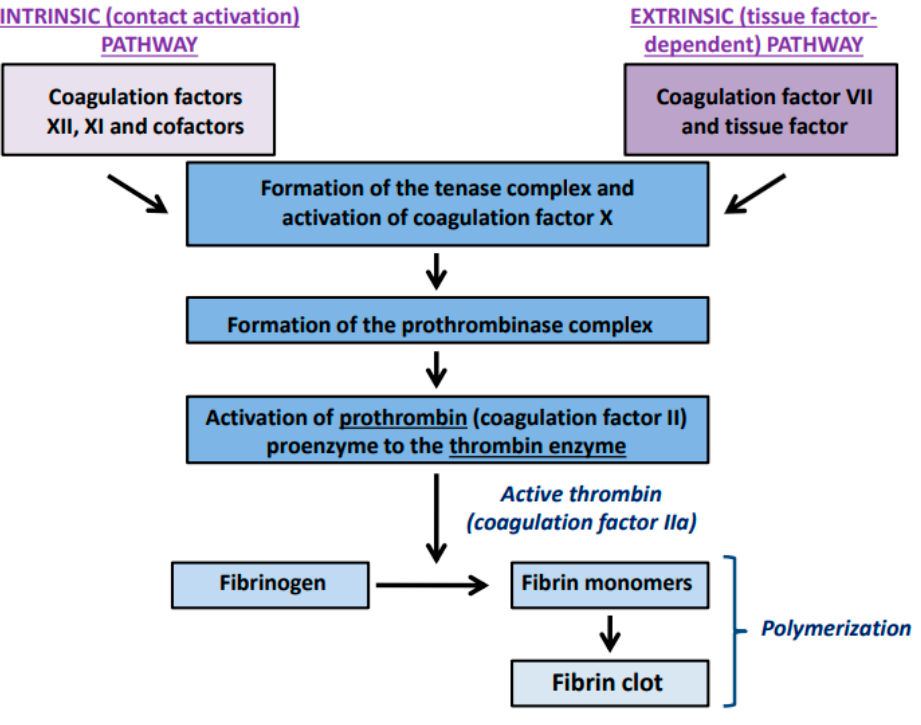
Figure 1. Key steps in the blood plasma coagulation cascade. The extrinsic pathway is activated by the tissue factor, which is abundantly expressed in the subendothelial tissue but becomes available to blood plasma proteins after vascular injury. Induction of the intrinsic coagulation pathway requires activation of the coagulation factor XII and the presence of a high-molecular (HMW) kininogen and prekallikrein. Independently on the starting point, both pathways trigger the tenase and prothrombinase enzymatic complexes, leading to the generation of the thrombin enzyme. The thrombin-catalyzed removal of short peptides from the fibrinogen molecule activates fibrinogen polymerization and the formation of fibrin monomers and polymers. This complex cascade of reactions results in the conversion of soluble fibrinogen into an insoluble fibrin clot.